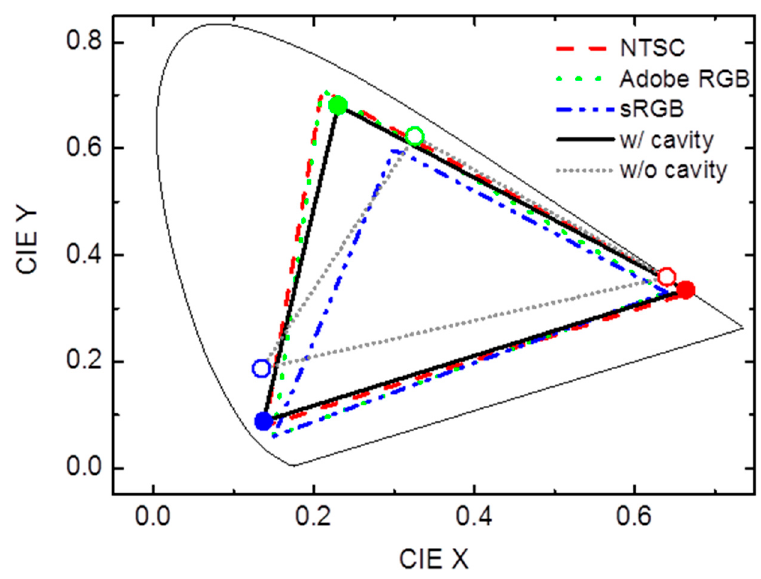
Figure 5. CIE 1931 chromaticity diagram with colour coordinates and the gamut of National Television System Committee (NTSC), Adobe RGB, sRGB, and R ( x = 150 nm), G ( x = 170 nm), B ( x = 140 nm) devices with (solid symbol) and without (open symbol) micro-cavity structure embedded cathodes.